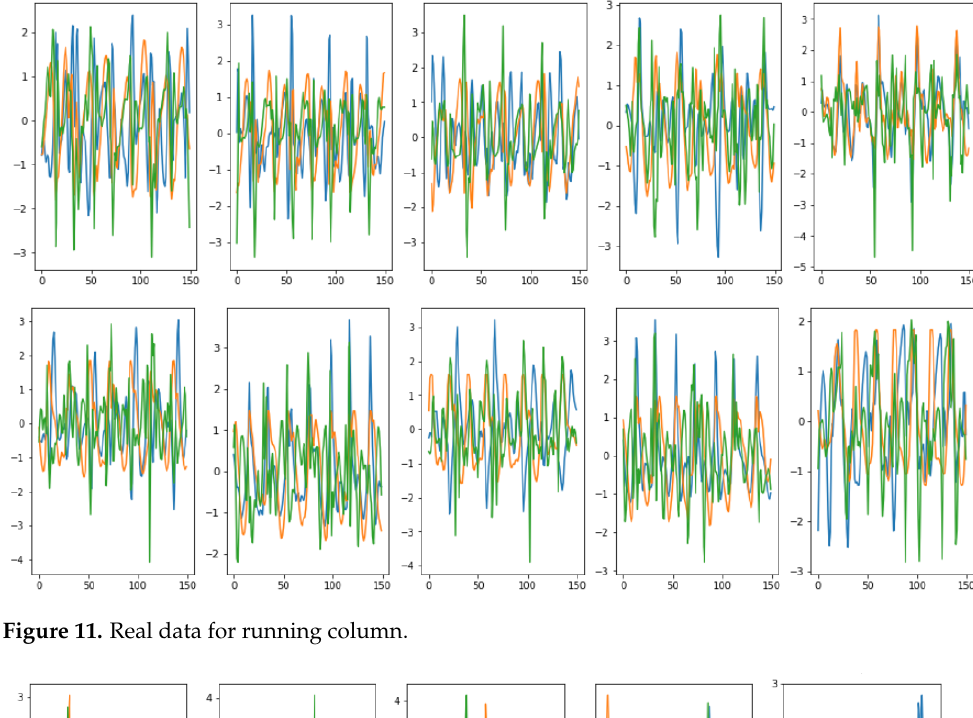
Figure 11. Real data for running column.